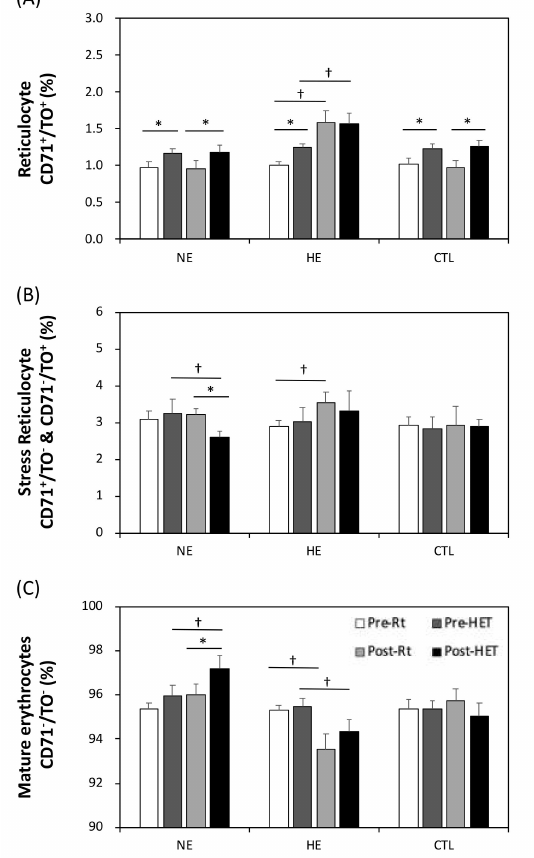
Figure 5. Measurement of erythrocyte composition: ( A ) the percentage of reticulocytes, ( B ) the percentage of stress reticulocytes, and ( C ) the percentage of mature erythrocytes. NE, normoxia training group; HE, hypoxia training group; CTL, control group; Pre, pretraining; Post, post-training; Rt, at rest; HET, immediately after HET; * p < 0.05, Rt vs. HET; † p < 0.05, pre vs. post. Values are the mean ±